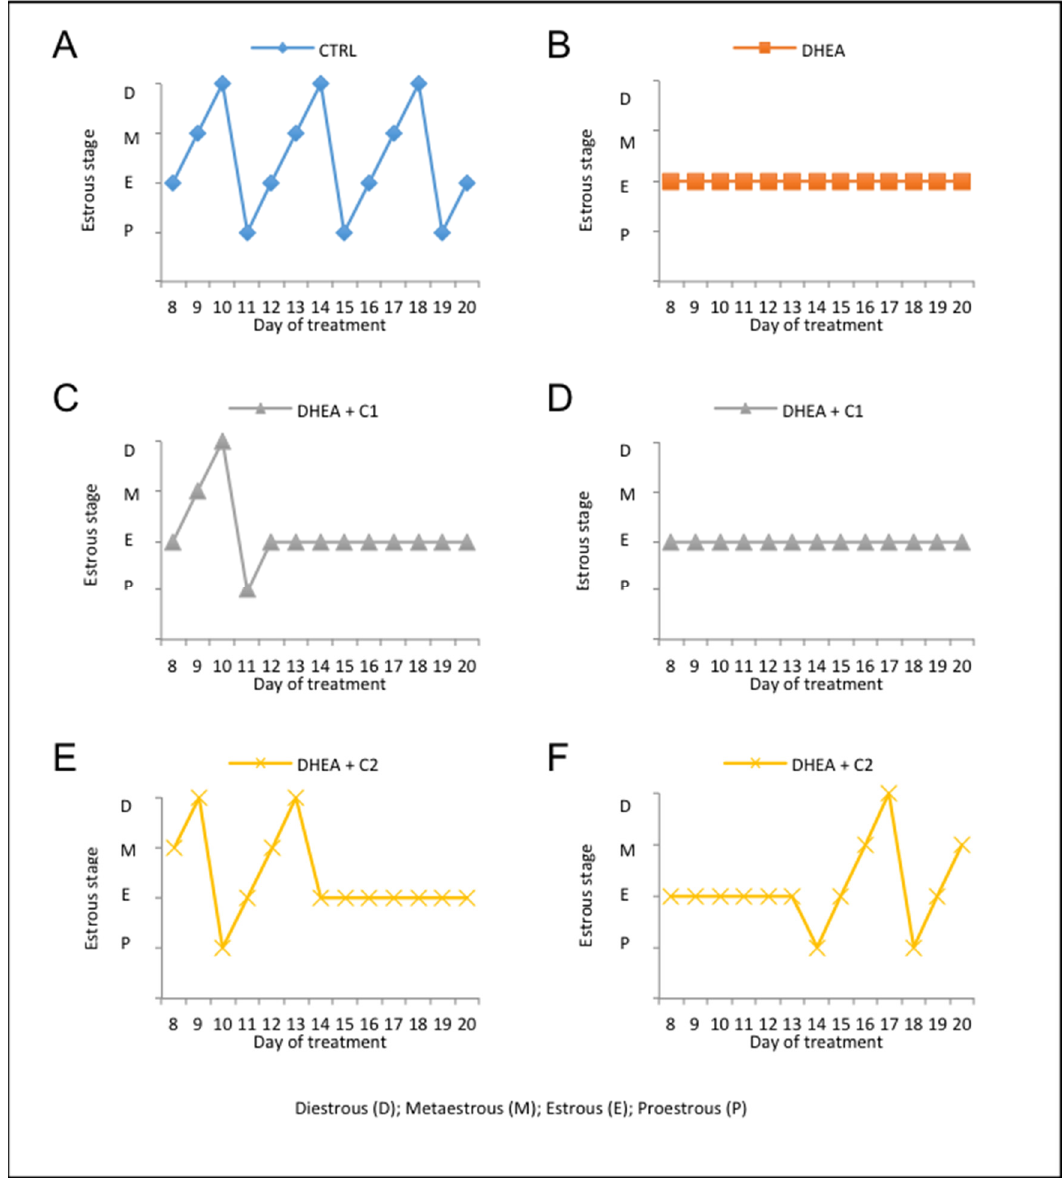
Figure 1. Administration of carnitine formulations ameliorated estrous cyclity disrupted by dehydroepiandrosterone (DHEA). The stages of the estrous cycle, assessed by analysis of vaginal smears, was performed daily from the seventh day after the first injection of DHEA. Representative estrous cycle of one mouse from control ( A ) and DHEA group ( B ). Representative estrous cycle of two mouse from DHEA + C1: 20% of DHEA + C1 mice showed normal estrous during the second week of treatment that was lost in the last week of treatment ( C ); 80% of DHEA + C1 mice did not present estrous during the whole length of treatment ( D ). Representative estrous cycle of two mice from DHEA + C2: 50% DHEA + C2 mice presented normal estrous in the second week of treatment only ( E ); 50% of DHEA + C2 mice showed normal estrous in the final week of treatment ( F ).